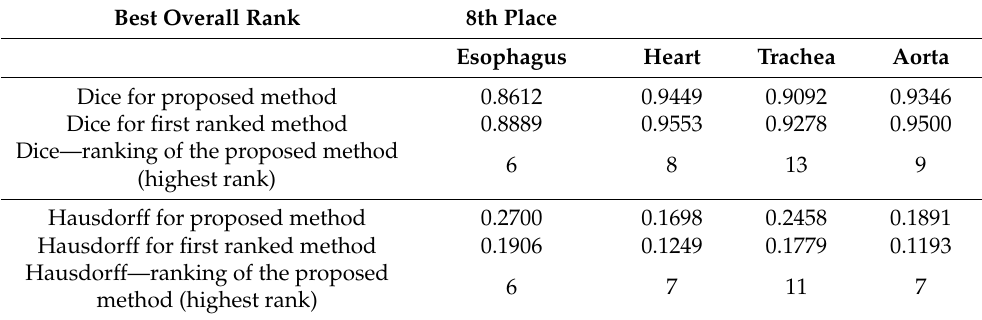
Table 3. Detailed results of our best submission.